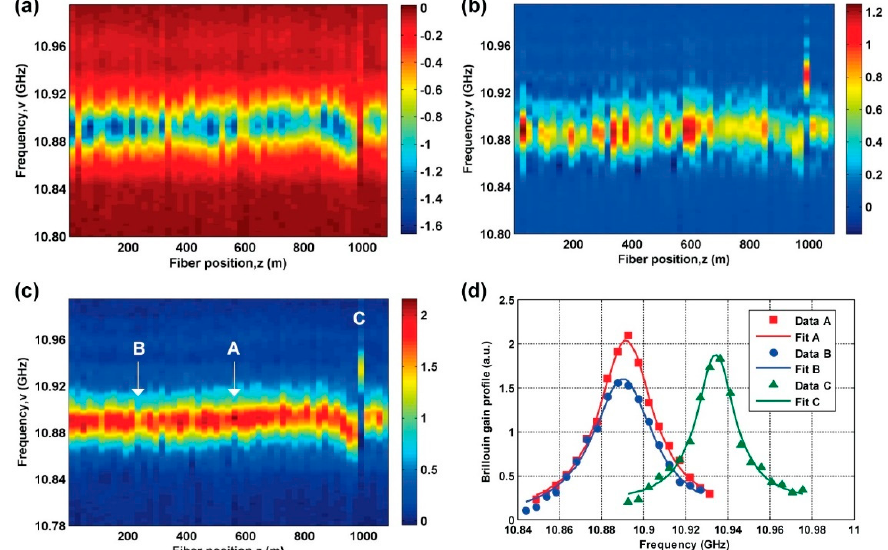
Figure 3. The results of the OFC-based fast BOTDA scheme [36]. The distributed BGS of the polarization axis: ( a ) x, ( b ) y, and ( c ) the combination. ( d ) The BGS at position A, B, and C. Experimental data: scatters. The curve-fittings curves: lines.